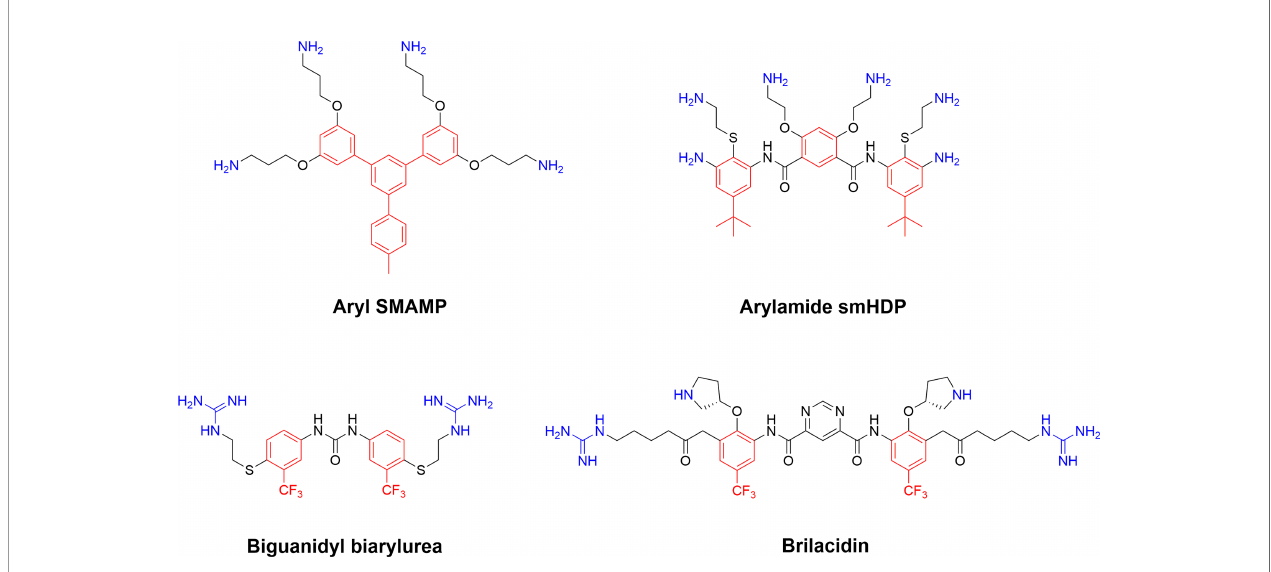
FIGURE 10 | Representative early SMAMPs illustrating the chemical diversity available to generate cationic synthetic amphiphilic compounds adhering to the AMP pharmacophore (40, 133). Briliacidin is currently being developed by Innovation Pharmaceuticals for a range of conditions such as ulcerative proctitis, oral mucositis, ABSSSI and as inhibitors for